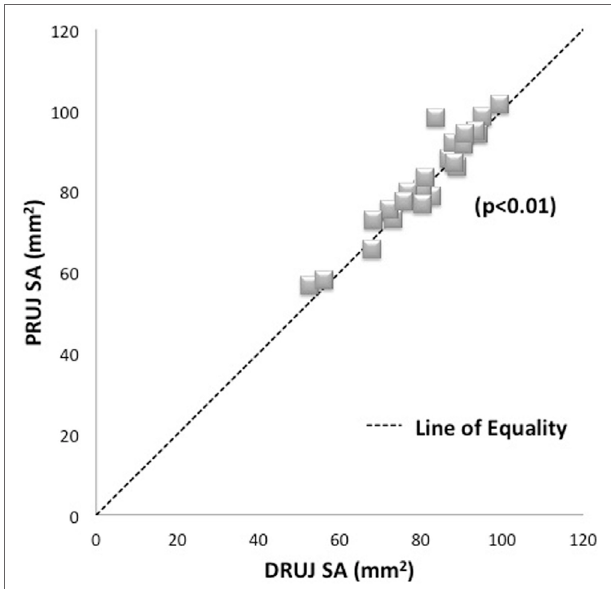
FigUre 2 | Plot of matched specimens PrUJ and DrUJ surface areas demonstrating average PrUJ/DrUJ ratio of 1.02 . Each specimen pair is represented by one dot with several pairs showing as superimposed (diamonds). The line of equality (dashed line) represents the theoretical situation where articulating surface areas are exactly the same as one another. Proximal radioulnar joint = PRUJ; distal radioulnar joint =